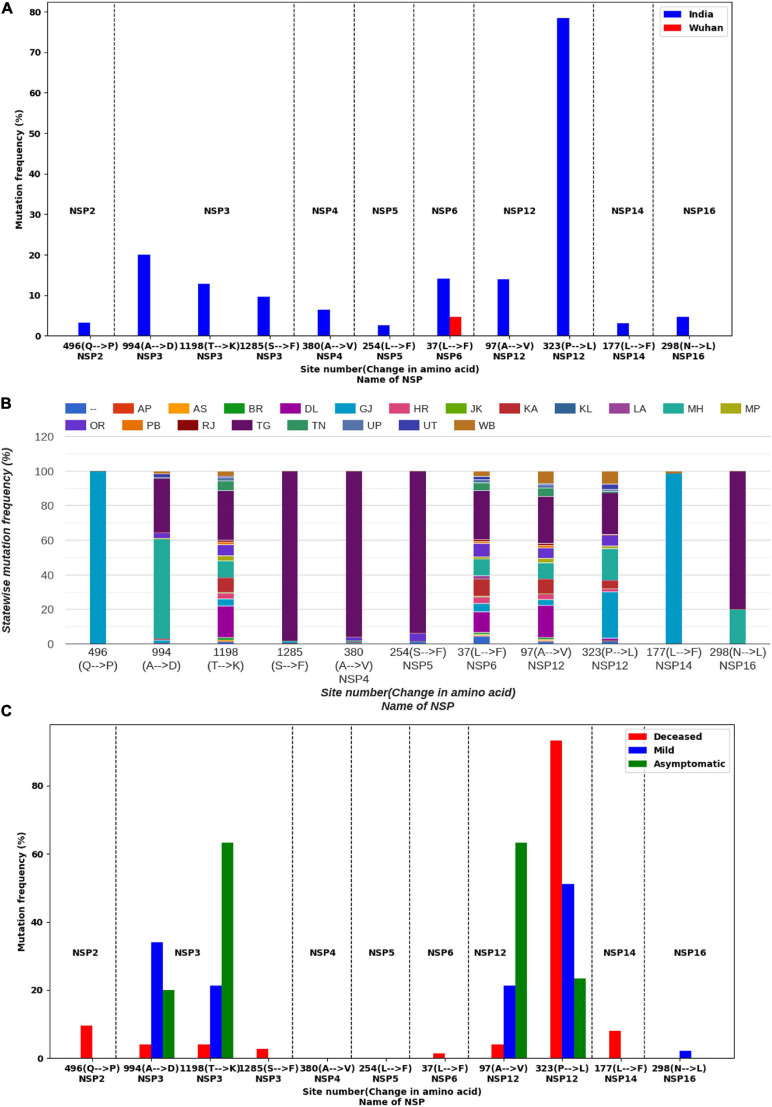
Mutation analysis of non-structural proteins (NSPs) of severe acute respiratory syndrome coronavirus 2 (SARS-CoV2) sequences having frequencies ≥2.5% in India. (A) Comparison of mutation frequencies for different NSPs from samples collected from India (blue) and Wuhan, China (red). Dashed lines are drawn to separate NSPs. (B) Distribution of mutations in different Indian states. (C) Occurrence of mutations in different types of patients.